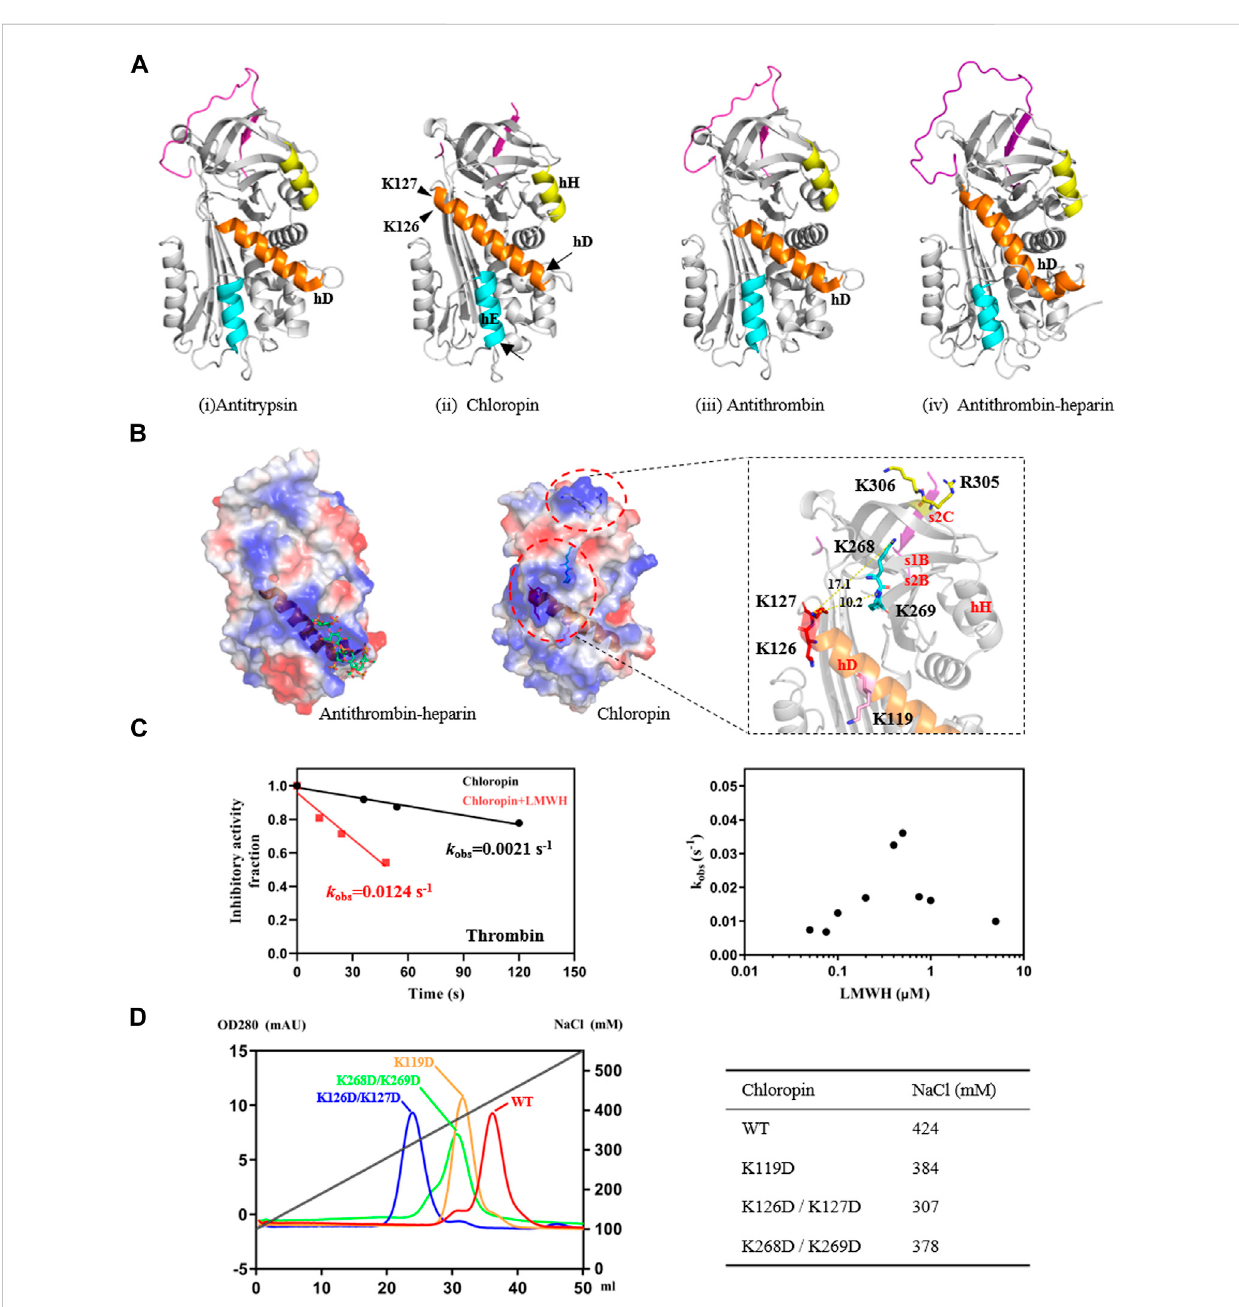
Identi fi cation of heparin-binding sites on chloropin. (A) Chloropin has similar structural con fi gurations as classic serpin such as antitrypsin (i, PDB 1QLP), antithrombin (iii, PDB 1ATH), and heparin-activated antithrombin (iv, PDB1AZX). Nevertheless, chloropin appeared to have a longer helix D with subtle shifts in the positions of helix E and H (ii). The lower part of helix D of antithrombin plays a key role during heparin activation of antithrombin with helix extensions at both ends (iii, iv). (B) Comparison of the electrostatic surfaces of heparin-activated antithrombin and chloropin. Heparin binds a positivelychargedpatchnearthelowerpartofhelixDinantithrombin(left).Incontrast,thereisapositivelychargedsurfaceareanearthetopofhelixDof chloropin involving residues K119, K126/K127, and K268/K269. Notably, R305 and K306 on top of chloropin are likely involved in the formation of the initial serpin-proteaseMichaeliscomplexasmutation ofthesetworesiduessigni fi cantly reduced thereaction between thrombinand chloropin (datanot shown). (C) Heparin stimulated thrombin inhibition by chloropin. Chloropin (0.4 μ M) in the presence or absence of 0.1 μ M heparin was incubated with 0.1 μ Mthrombinfordifferenttimeintervalswiththeremainingproteaseactivitiesplottedtoobtainthe k obs values.Therewasa~6-foldincreaseinthe k obs in the presence of 0.1 μ M heparin (left) and the acceleration is heparin dose-dependent following a bell-shaped curve (right). (D) Heparin-binding af fi nities of chloropin variants were assessed by a Hitrap heparin column with the salt concentrations in peaks identi fi